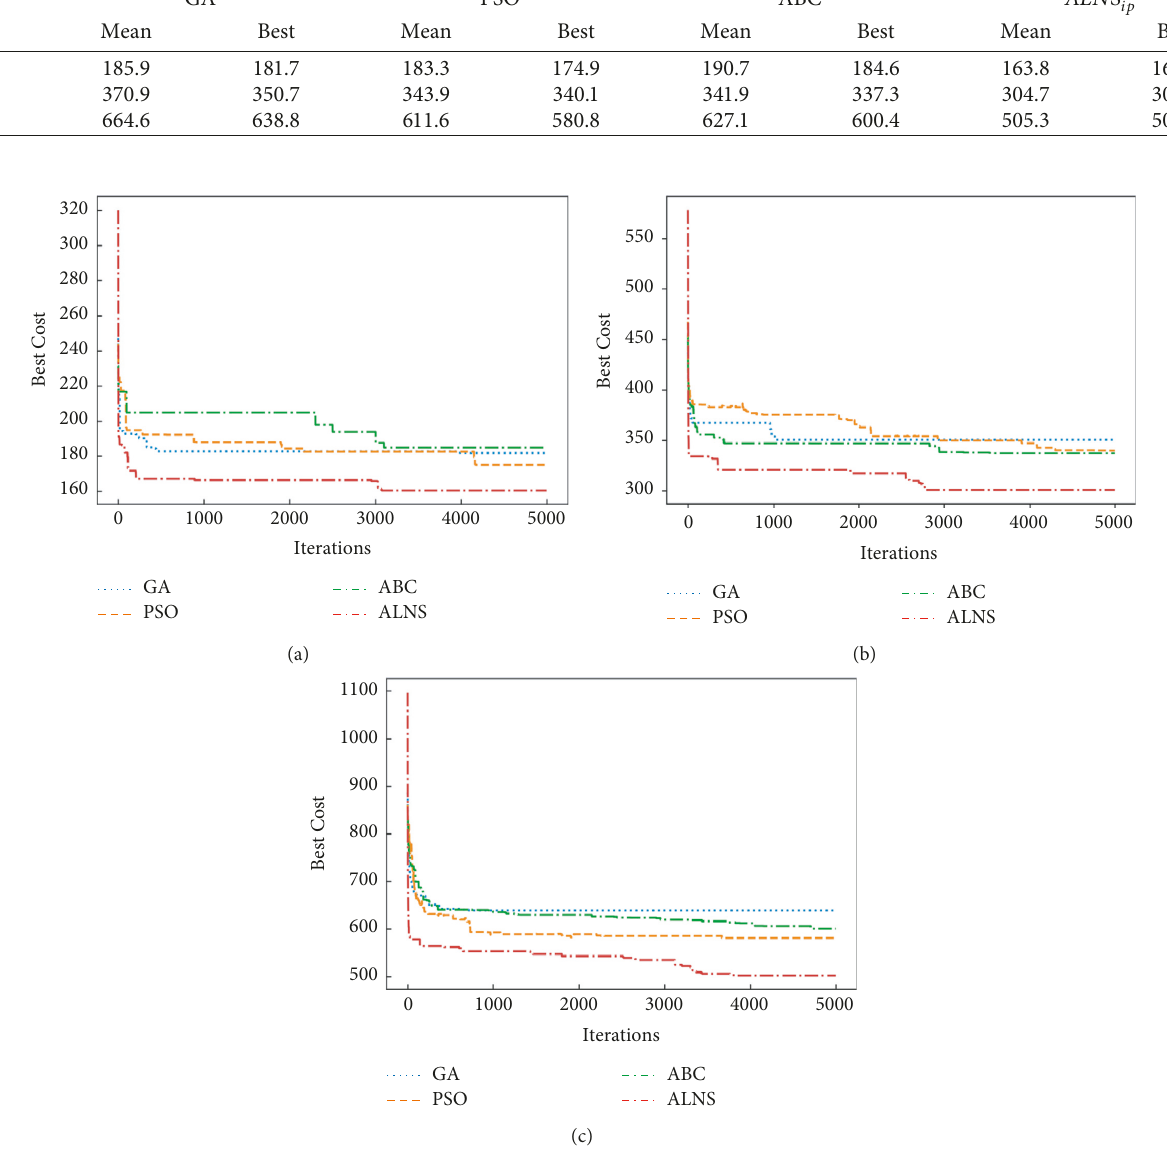
Figure 5: Convergence graph obtained for ALNS ip , GA, PSO, and ABC algorithms. (a) R1b. (b) R2b. (c)